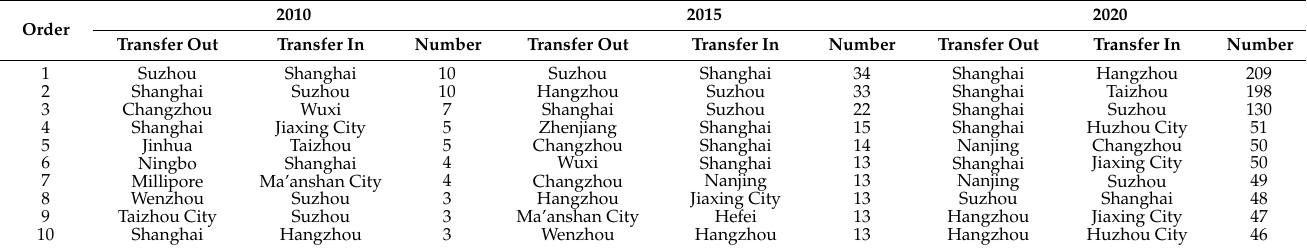
Table 2. Top 10 intercity links of green technology transfer in